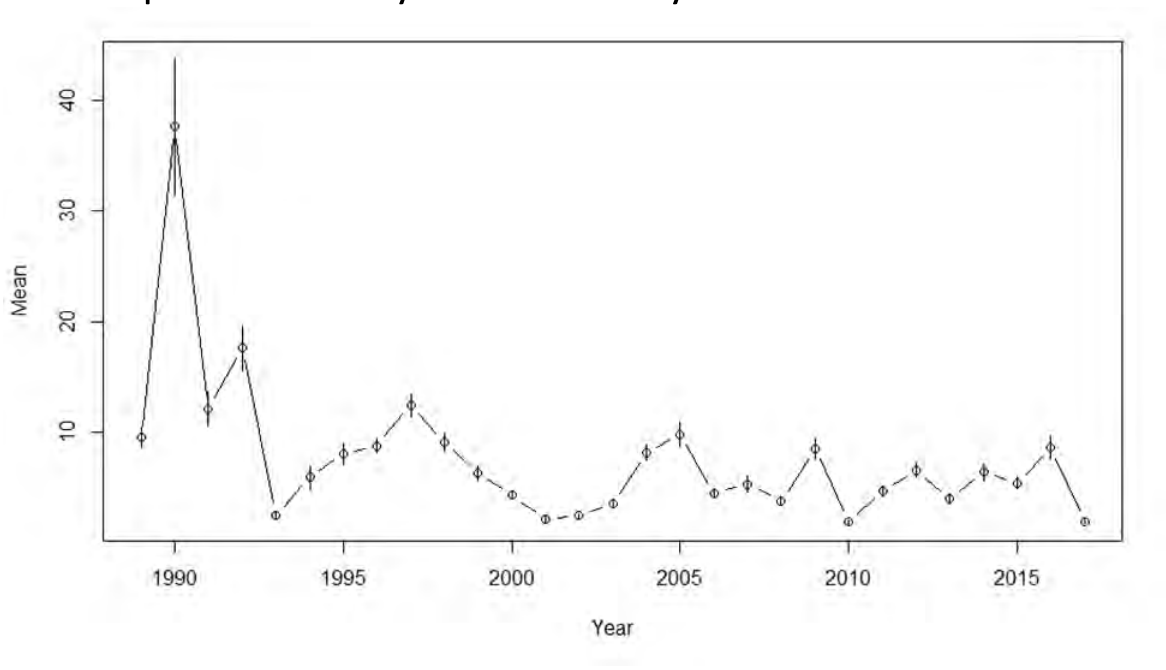
Figure 44. Abundance index for all horseshoe crabs in the fall (October) samples from New Jersey’s Ocean Trawl